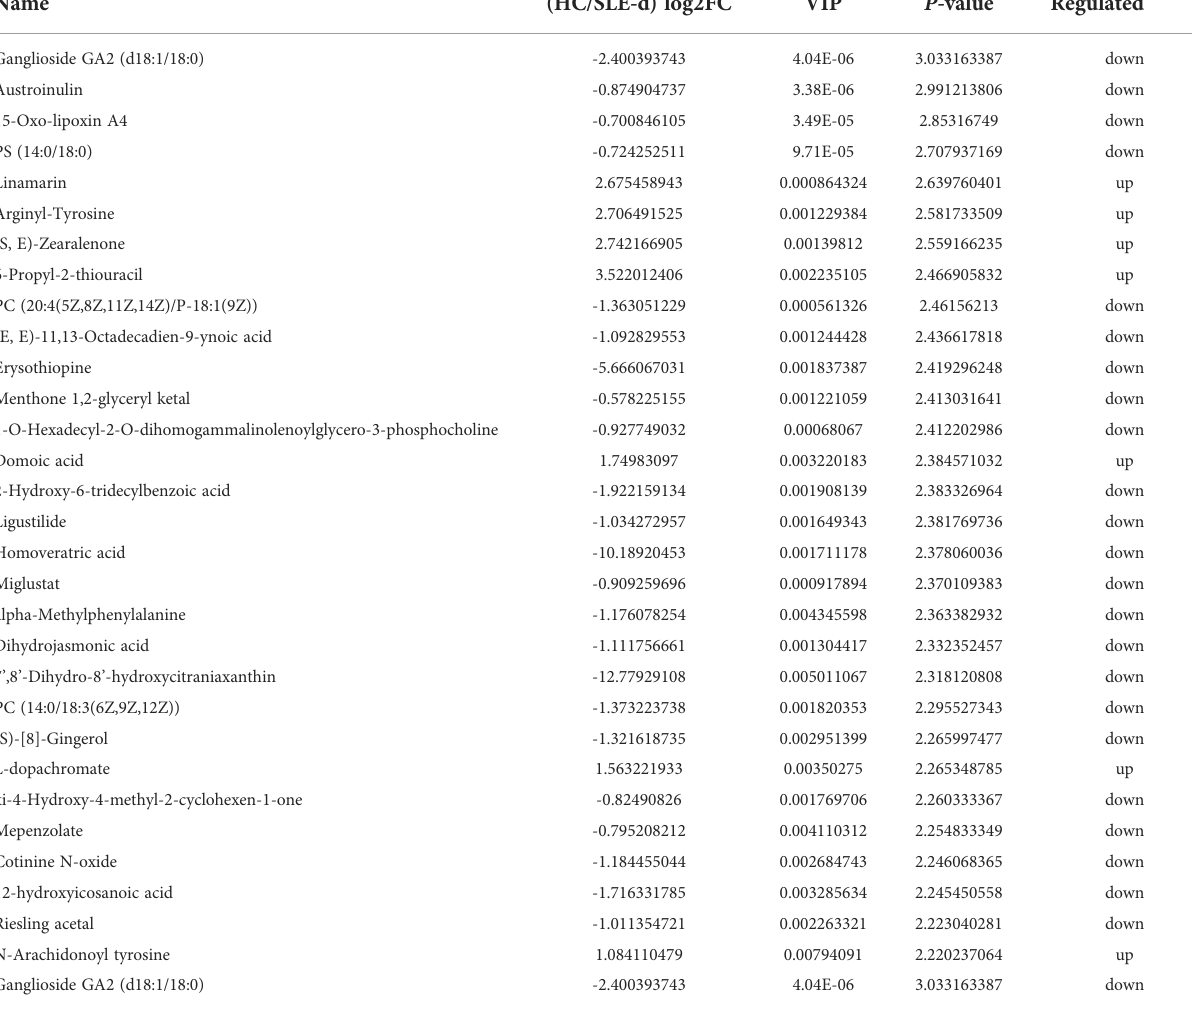
TABLE 2 Fecal identi fi ed part differential metabolites between SLE-d patients and healthy